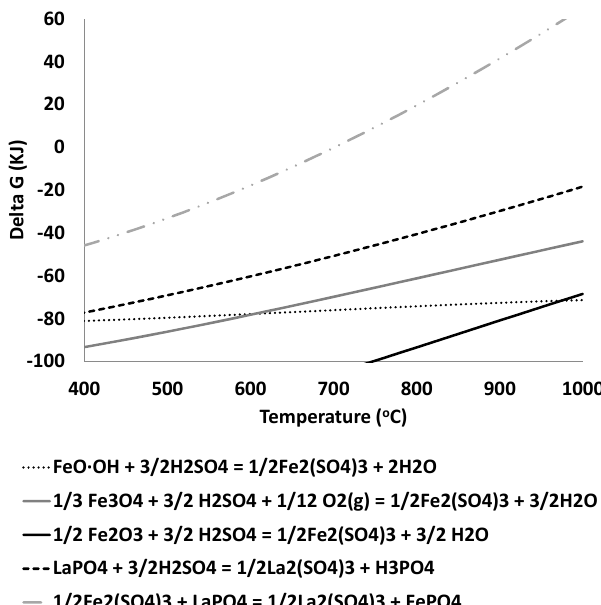
∆ G) of reactions 5, 6 and 7 (kJ) from 400 ◦ C to 1000 ◦ Figure 3. Free energy (Delta G— Δ G) of reactions 5, 6 and 7 (kJ) from 400 °C to 1000 °C. Figure 3. Free energy (Delta G—